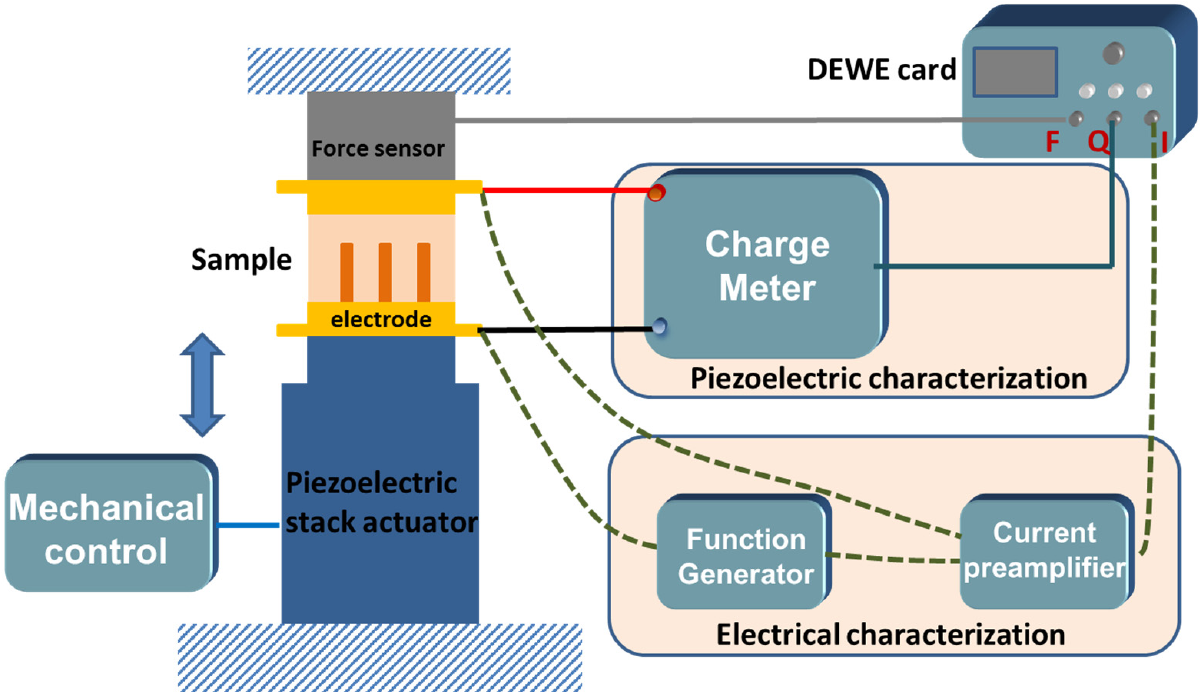
Figure 3. Schematics of an experimental setup for piezoelectric and electrical characterizations.